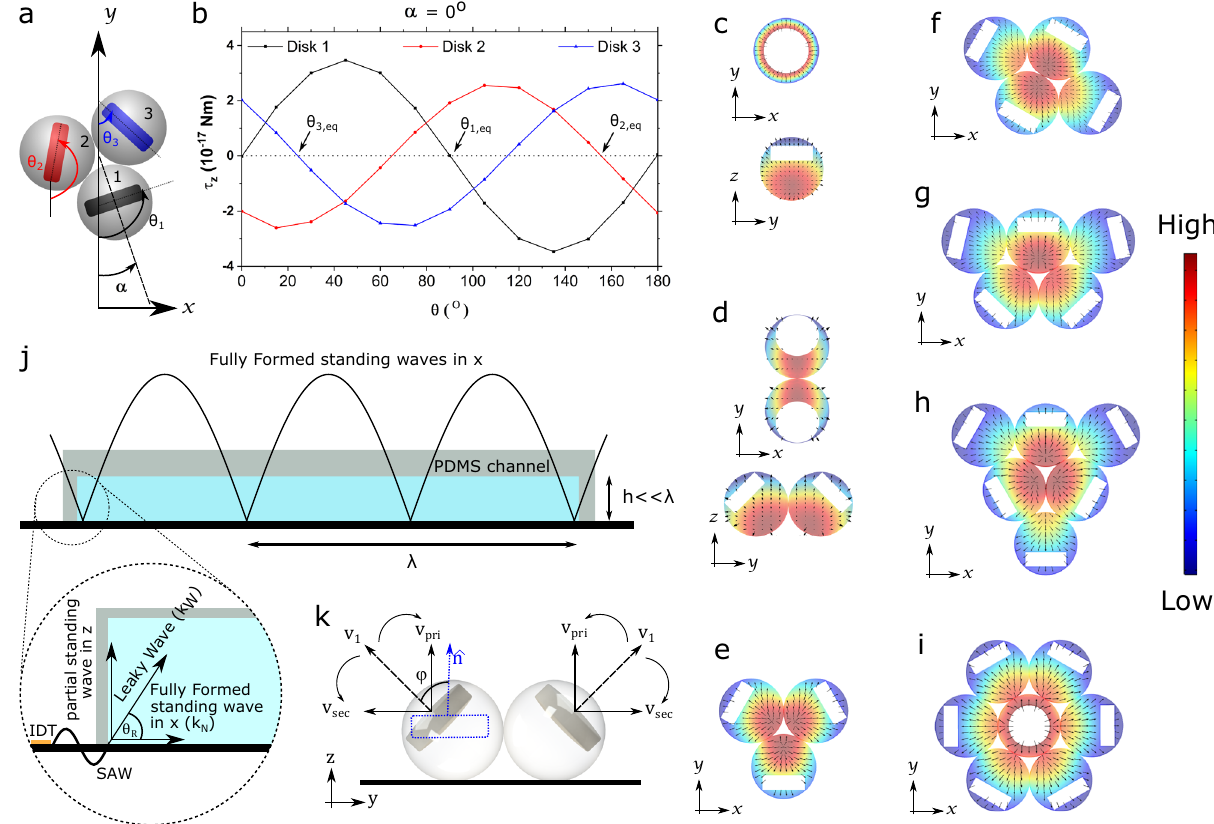
Fig. 4 Understanding disk orientation behavior. a Schematic of disk orientation angles inside a trimer system plotted in b. b Torque τ z on inner disks inside a trimer cluster vs. disk orientation angle from COMSOL simulations. The equilibrium angles θ eq (shown by arrows), i.e., equilibrium orientations are determined by the zero torques with negative slope. Source data are provided as a source data fi le. c . Simulation results showing the effect of standing SAW on clusters with 1 droplet ( c ), 2 droplets ( d ), 3 droplets ( e ), 4 droplets ( f ), 5 droplets ( g ), 6 droplets ( h ) and 7 droplets ( i ). The simulation results match the experimental observations of the droplet clusters shown in Fig. 2c – g, Supplementary Fig. 2. j Schematic showing the generation of fully formed standing wave in the x-direction and partial standing wave in the z direction (due to restricted channel height). k Schematic showing the disk orientation inside the droplet is a result of the interplay between the primary and secondary radiation forces. φ is the angle between v 1 and the disk axis (shown in dotted blue for one of the droplets, with a random orientation, in a non-equilibrium position). At equilibrium torque, the disk radial symmetric axes should align with particle velocity v 1 direction ( φ = 0), which is a sum of contributions from primary radiation v pri (along z-axis for all disks) and the secondary radiations v sec (along radial direction away from the droplet cluster, i.e., y-axis for a two-droplet